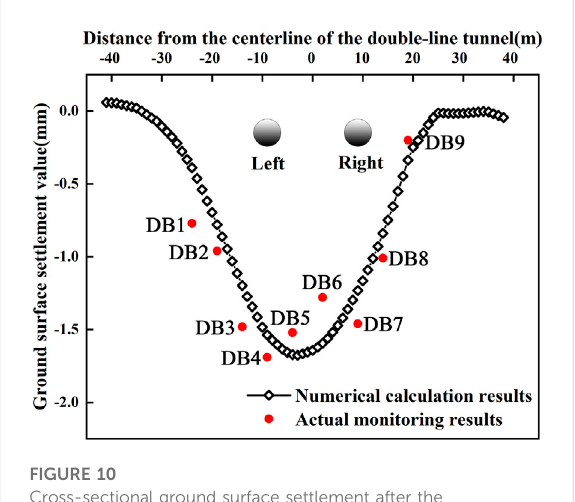
FIGURE 10 Cross-sectional ground surface settlement after the completion of the double-line tunnel boring (K36 +